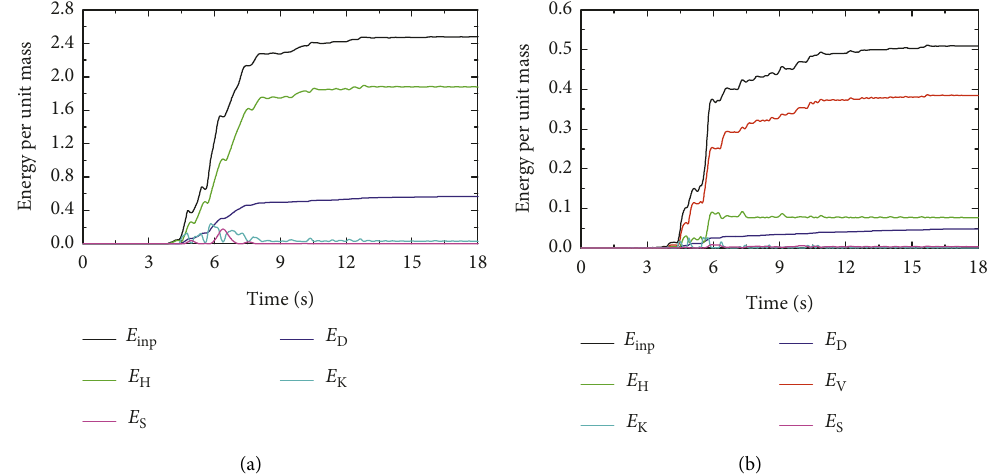
Figure 8: Time-history energy response of the SDOF structure subjected to pulse excitation: (a) uncontrolled structure and (b) structure with VDs.